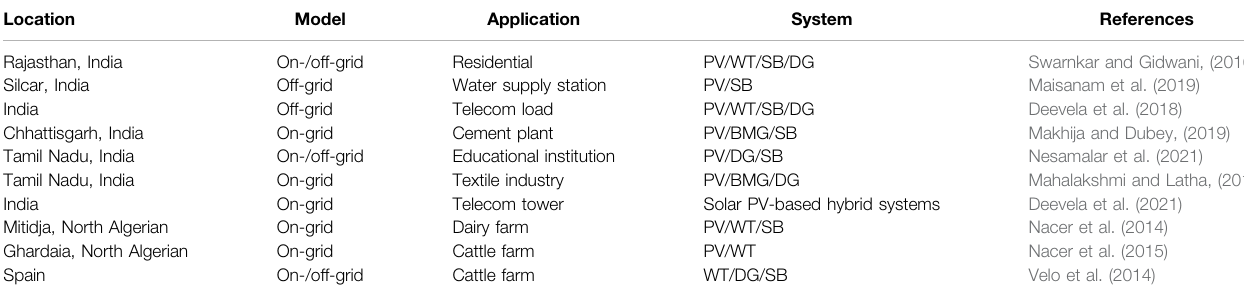
TABLE 1 | Design of hybrid renewable energy systems for various applications.